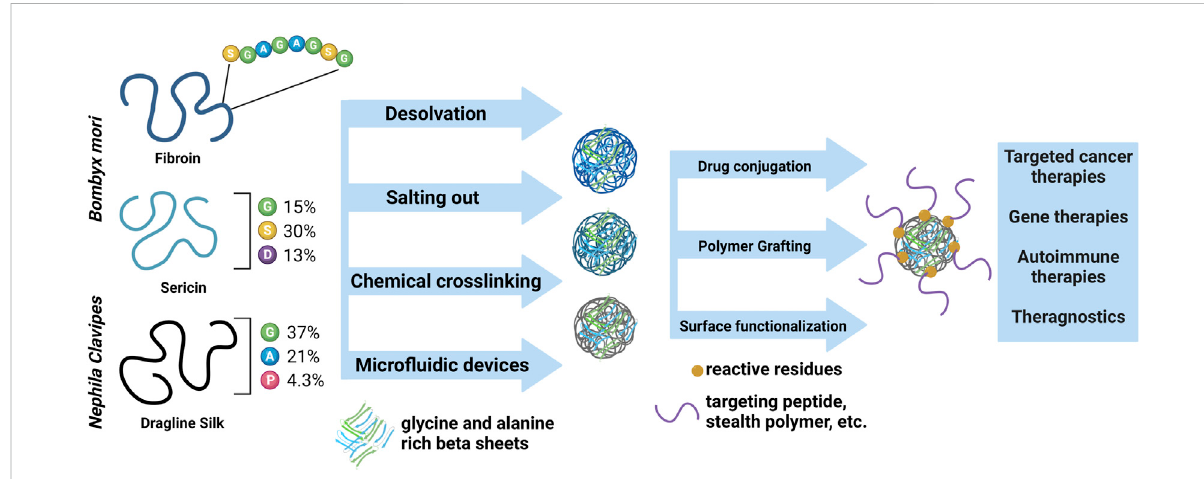
FIGURE 1 Common methods for silk biopolymer-based nanomaterial fabrication and